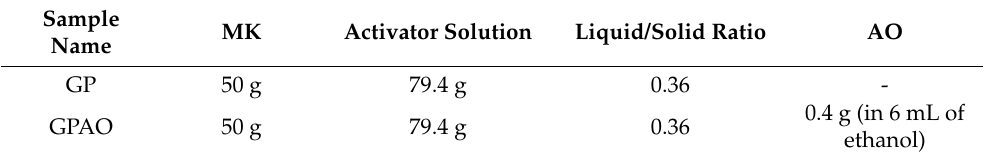
Table 2. Mixture details of geopolymers with and without the organic dye.